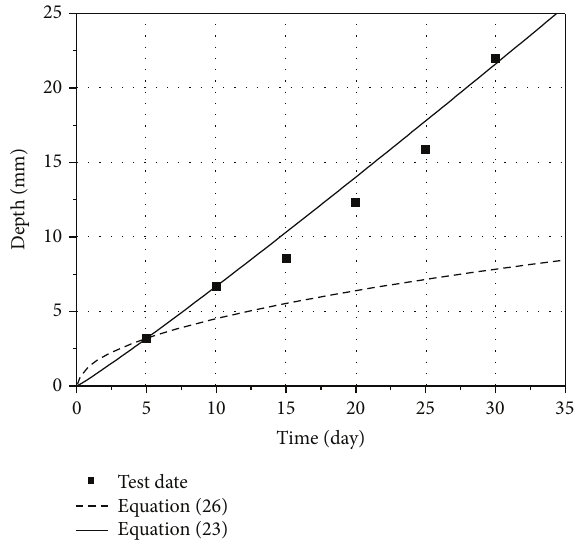
Figure 4: Prediction of Model (23) compared with the experimental results.